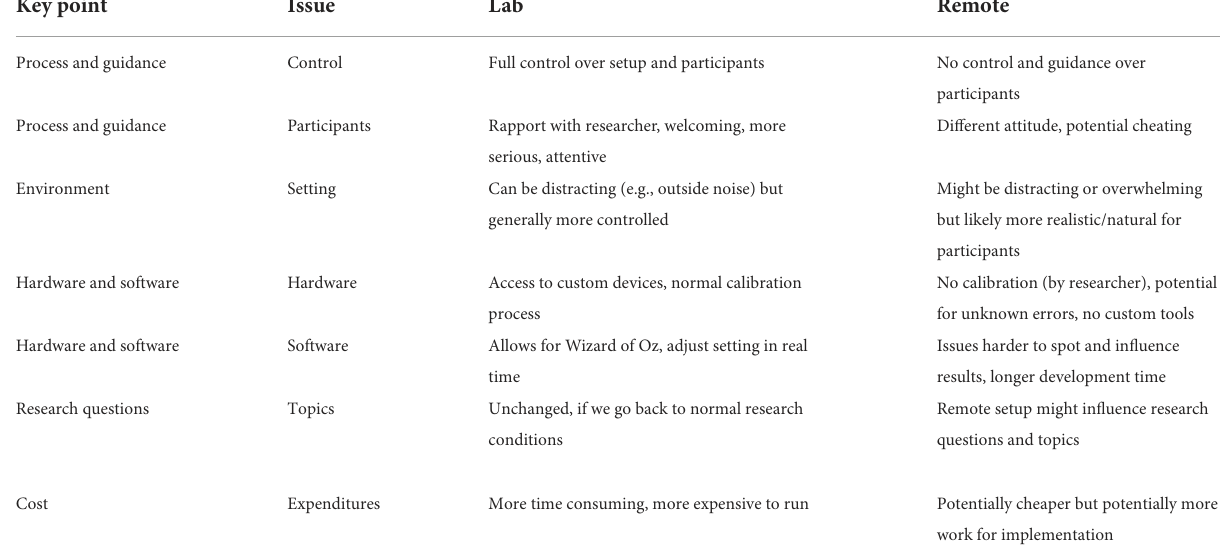
TABLE 4 Experiment process key